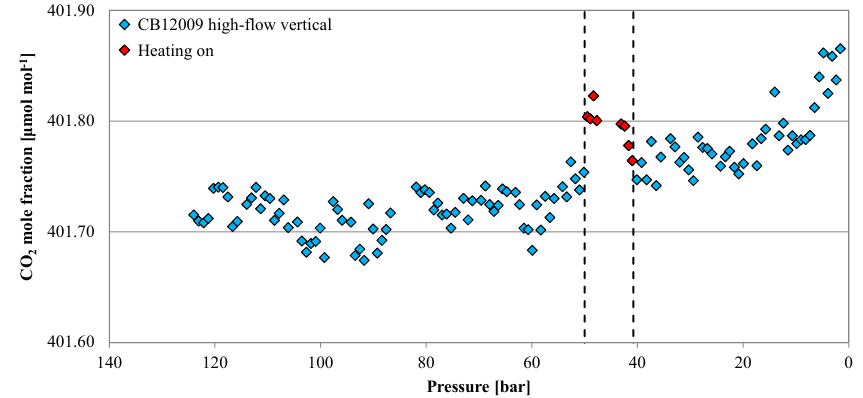
Figure 17. CO 2 mole fraction of a high-flow experiment as a function of pressure; note the inverse x axis. The cylinder (CB12009 on 26 September 2017) was vertically positioned throughout the whole experiment. The CO 2 mole fraction was measured down to 50bar (blue diamonds). At 50bar (indicated by the first dashed line), the heating was switched on but the CO 2 measurements continued during the heating phase (red diamonds). After the heating’s thermostat indicated that the cylinder reached 30 ◦ C, the heating was switched off (indicated by the second dashed line) and the CO 2 mole fraction was measured until the end (again blue